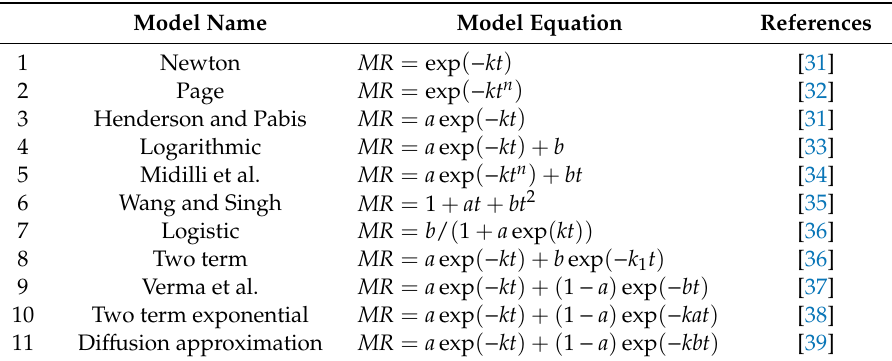
Table 1. Mathematical models applied to the drying curves in the